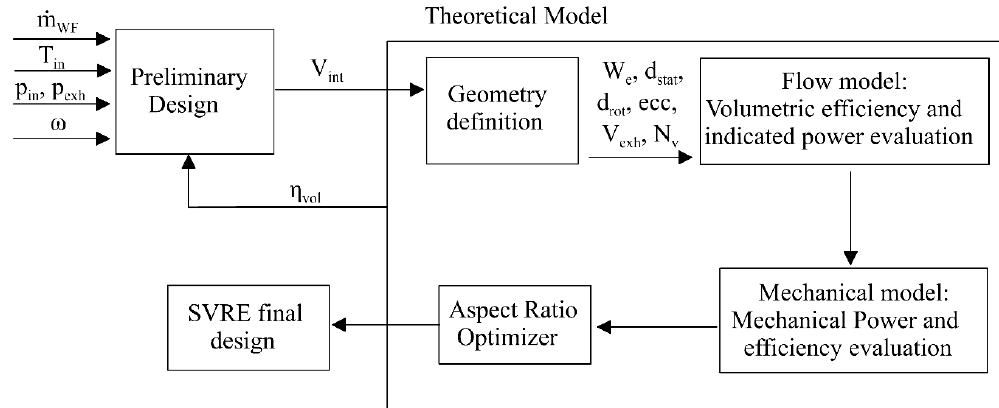
Figure 8. Scheme of the design model .